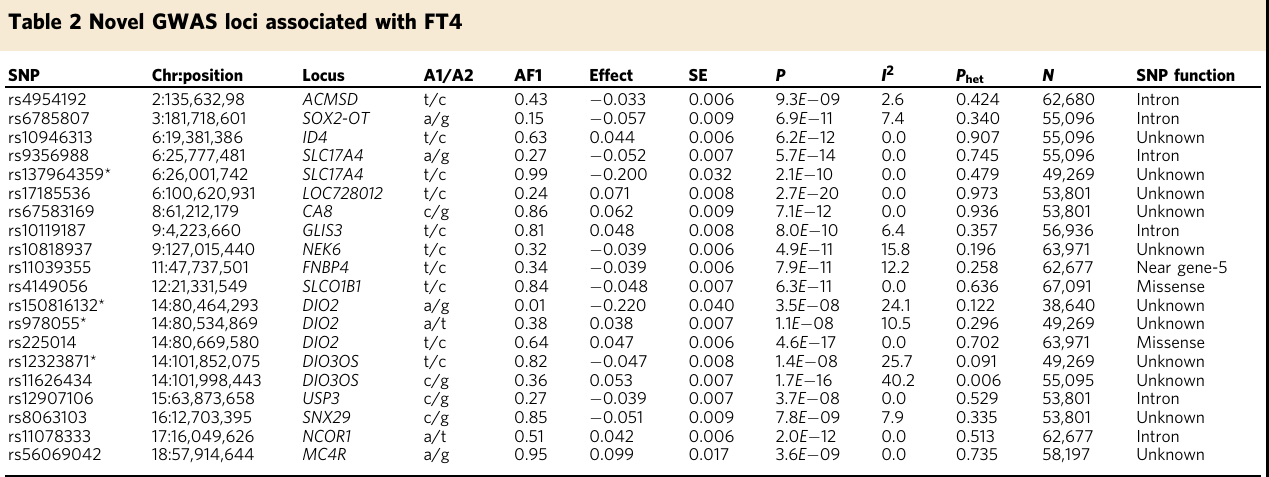
Table 2 Novel GWAS loci associated with FT4